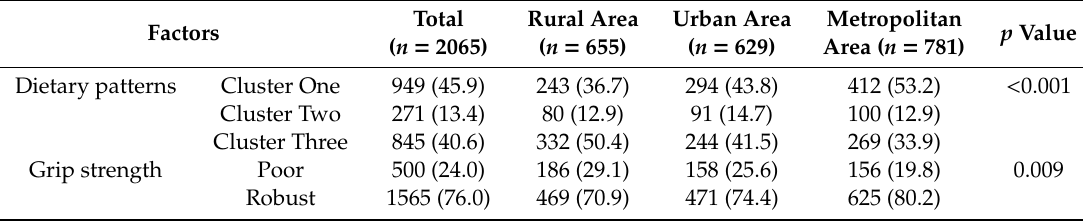
Table 2. Dietary patterns and grip strength by residential areas.